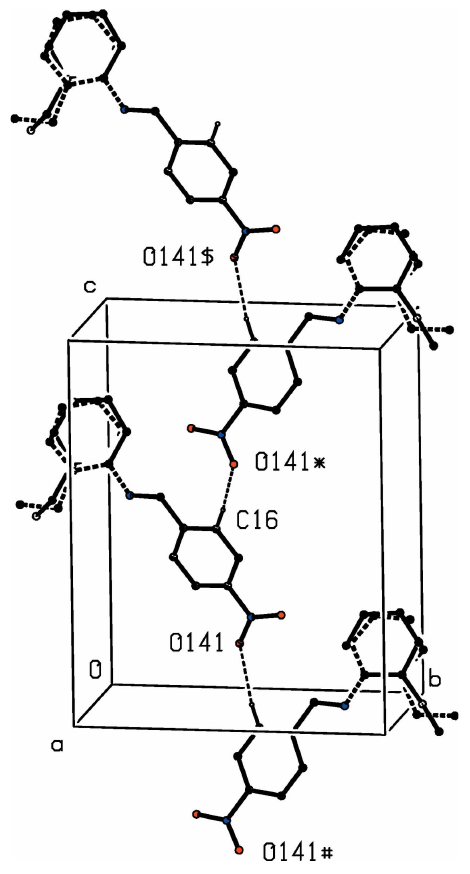
Figure 2 Part of the crystal structure of compound (I) showing the formation of a C (6) hydrogen-bonded chain along [001]. For the sake of clarity, the H atoms not involved in the motif shown have been omitted. The atoms marked with an asterisk (*), a hash (#) or a dollar sign ($) are at the (cid:5) x , 1 (cid:5) y , 1 (cid:5) x , 1 (cid:5) y , symmetry positions ( 3 + z ), ( x , y , 1 + z ) and ( 3 2 2 2 (cid:5) 1 + z ), respectively. For the disordered 2-ethylphenyl group, the major 2 component is drawn using solid lines and the minor component is drawn using dashed